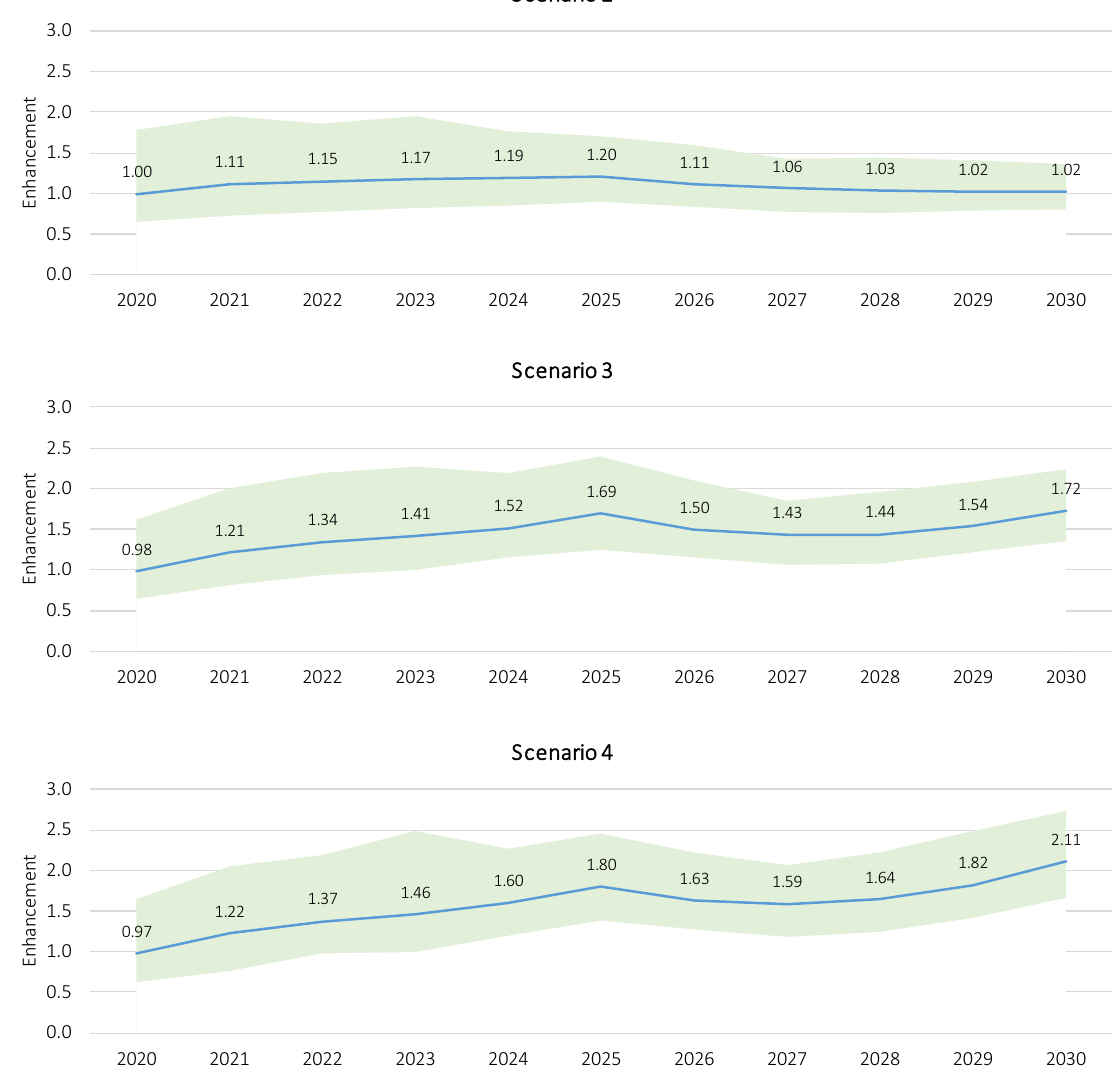
Figure 6. Simulation results for the different scenarios (BEV and PHEV accumulated).